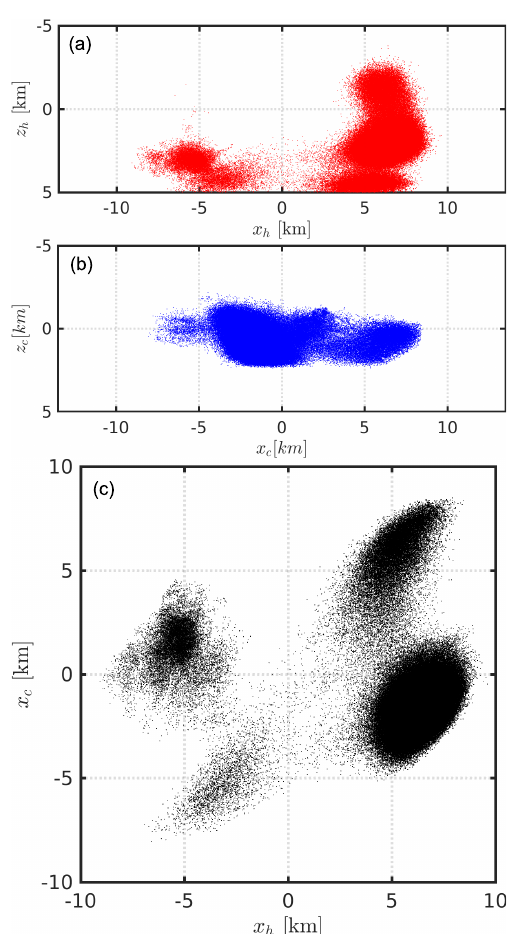
Figure 14. Restricted Bayesian MCMC sample chains of the hypocenter (a) and elliptical patch center (b) ; panel (c) shows the correspondence between x h and x c chains.